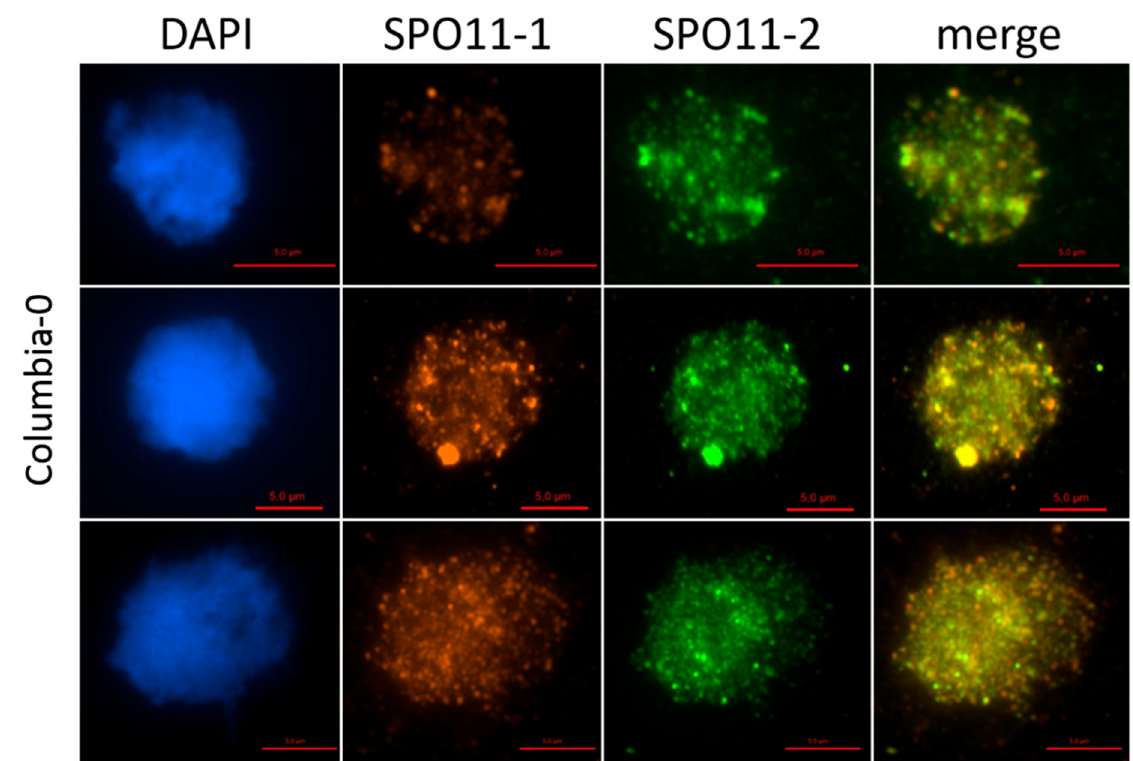
Figure 5. Dual immunolocalization of SPO11-1 and SPO11-2 proteins in meiocytes of Arabidopsis Col-0 plants. Meiocytes were counterstained with DAPI (A) and dual immunolocalization of SPO11-1 and SPO11-2 was performed, single channel pictures were merged afterwards. Mouse polyclonal IGg antibody against SPO11-1 and rabbit polyclonal IGg antibody against SPO11-2 was used. Bar = 5 µm.